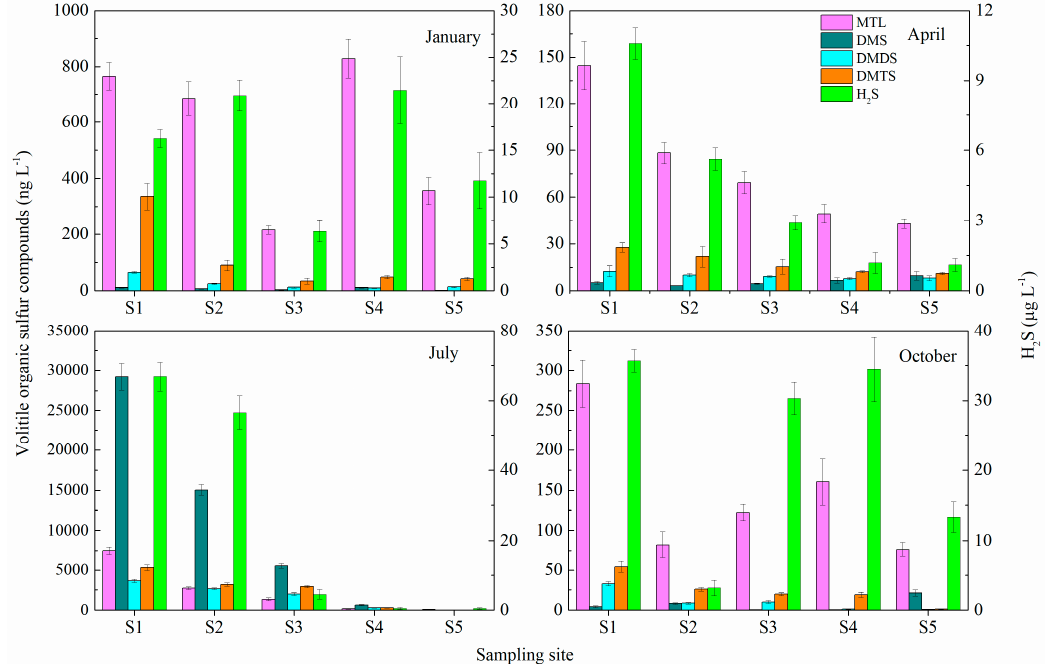
Figure 5. Concentrations of volatile sulfur compounds in water during the field investigation period. Error bars indicate the standard deviation, n=3.